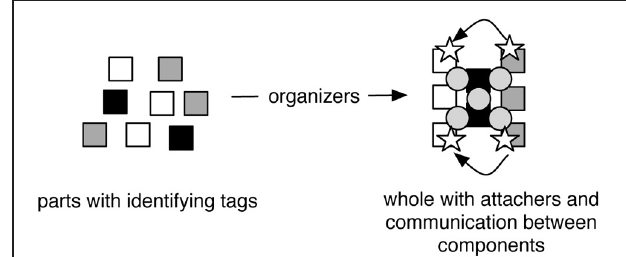
FIGURE 1 | Organization at a given level. Squares represent components with different tags represented by different shades. The organizers arrow represents ongoing processes that pattern the structural and functional arrangement of parts into a whole. Circles represent attachers. Stars represent communicators that move between parts as indicated by curved arrows.